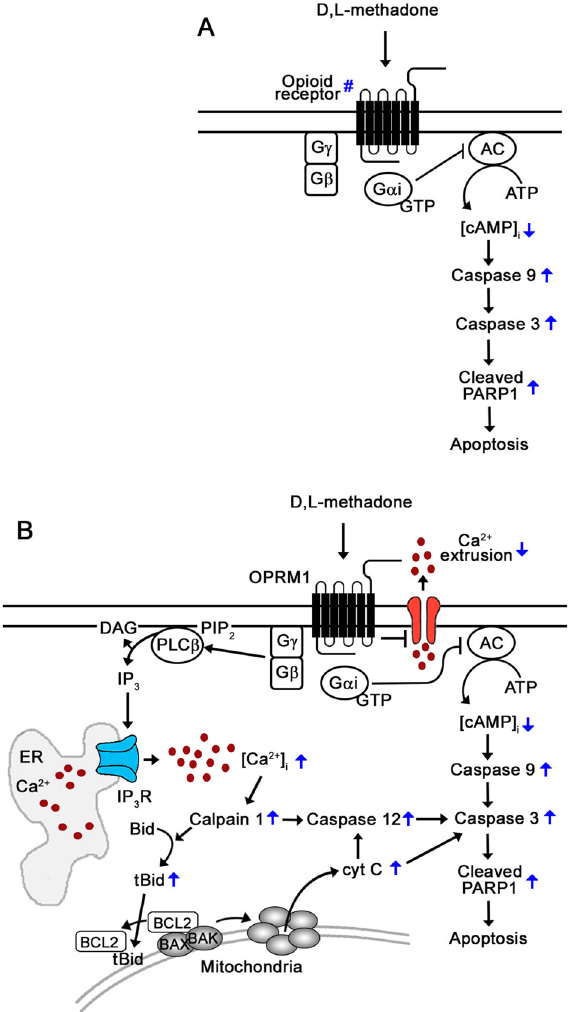
Figure 7. Proposed mechanism for OPRM1-mediated d,l-methadone-induced apoptosis in leukemic cells. ( A ) Previously, stimulation of an unidentified type of opioid receptor (#) by d,l-methadone was shown to induce leukemic cell death via G αi , which blocks adenylyl cyclase activity that in turn reduces [cAMP] i , activating caspase-9 and -3 5 . ( B ) In the current study, we identify the OPRM1 opioid receptor as a specific d,l-methadone target in leukemic cells. Since activation of opioid receptors has been shown to cause G βγ - mediated rise in [Ca 2+ ] i via PLC 22,26–28 , we propose that d,l-methadone activation of OPRM1 in leukemic cells causes G βγ -mediated stimulation of PLC, which then triggers a rise in [Ca 2+ ] i through increased IP3R-mediated ER Ca 2+ release and reduced rate of Ca 2+ efflux, causing upregulation of the Ca 2+ -mediated calpain-1-Bid-cyt C-caspase-3/12 apoptotic pathway and subsequent